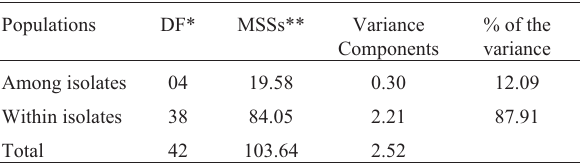
Table4 -Molecularvarianceanalysis(AMOVA)of Fusariumoxysporum f. sp. phaseoli